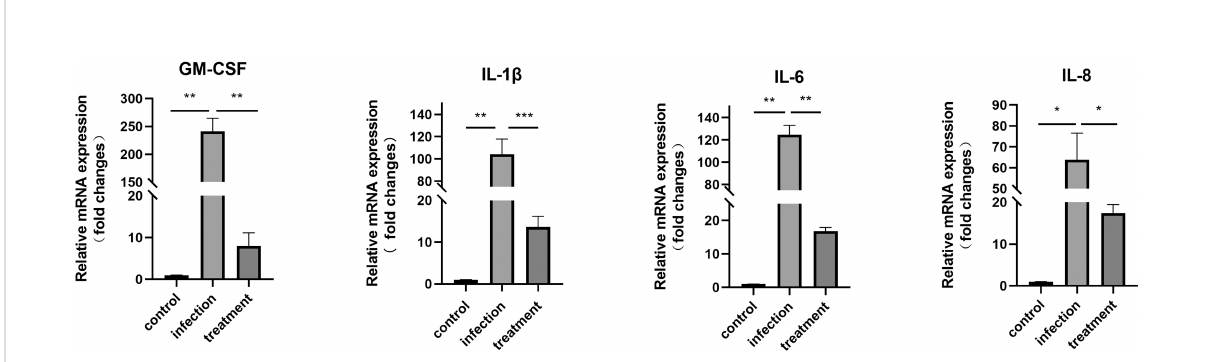
FIGURE 3 mRNA expression of GM-CSF, IL-1 b , IL-6 and IL-8 in T. gondii -infected RPE cells was veri fi ed by qRT-PCR after 48 h of LBH589 treatment. Normal RPE cells served as the control. * P < 0.05, ** P < 0.01, *** P < 0.001. Each experiment was repeated independently three times, with three wells of each